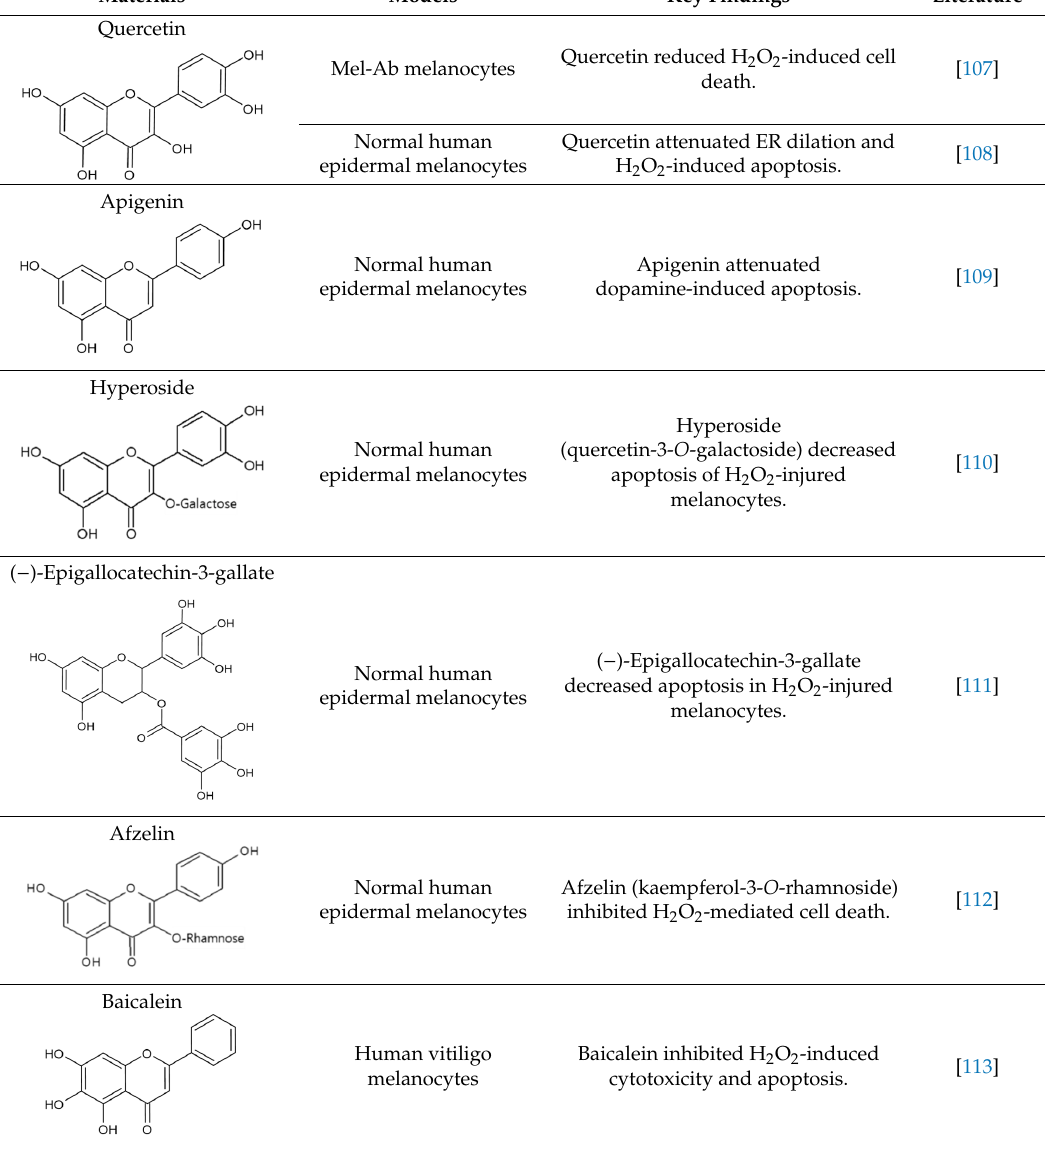
Table 2. Cytoprotective effects of plant-derived antioxidants in melanocytes. Materials